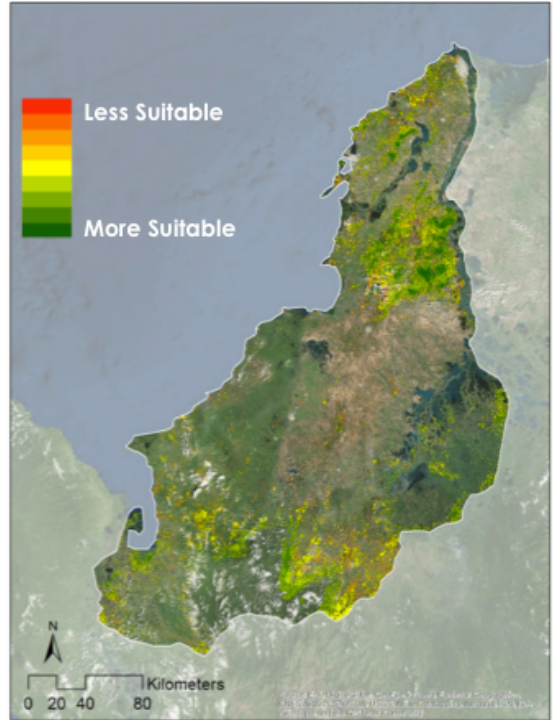
Figure 2. Suitable areas for